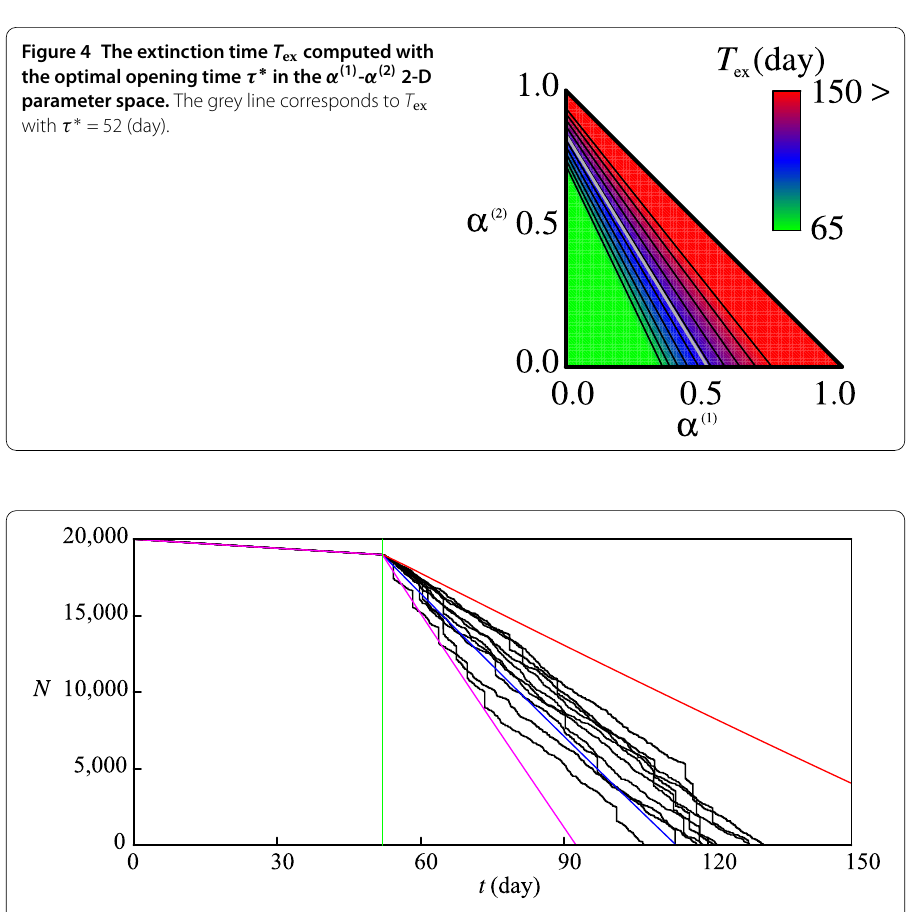
Figure 4 The extinction time T ex computed with the optimal opening time τ ∗ in the α (1) - α (2) 2-D parameter space. The grey line corresponds to T ex with τ ∗ = 52